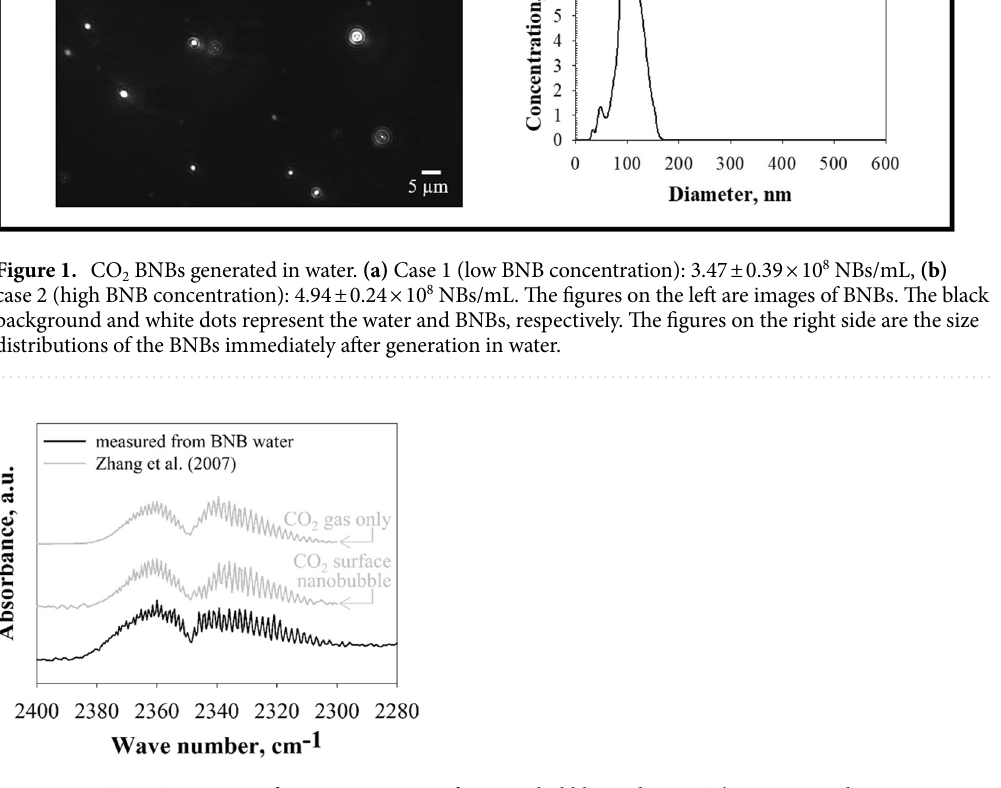
Figure 2. ATR-FTIR spectra of gaseous CO 2 in surface nanobubbles and BNBs. The spectrum shows two groups of distinct fine peaks attributed to CO 2 gas molecules. The spectrum of BNB suspensions demonstrates the formation of gaseous CO 2